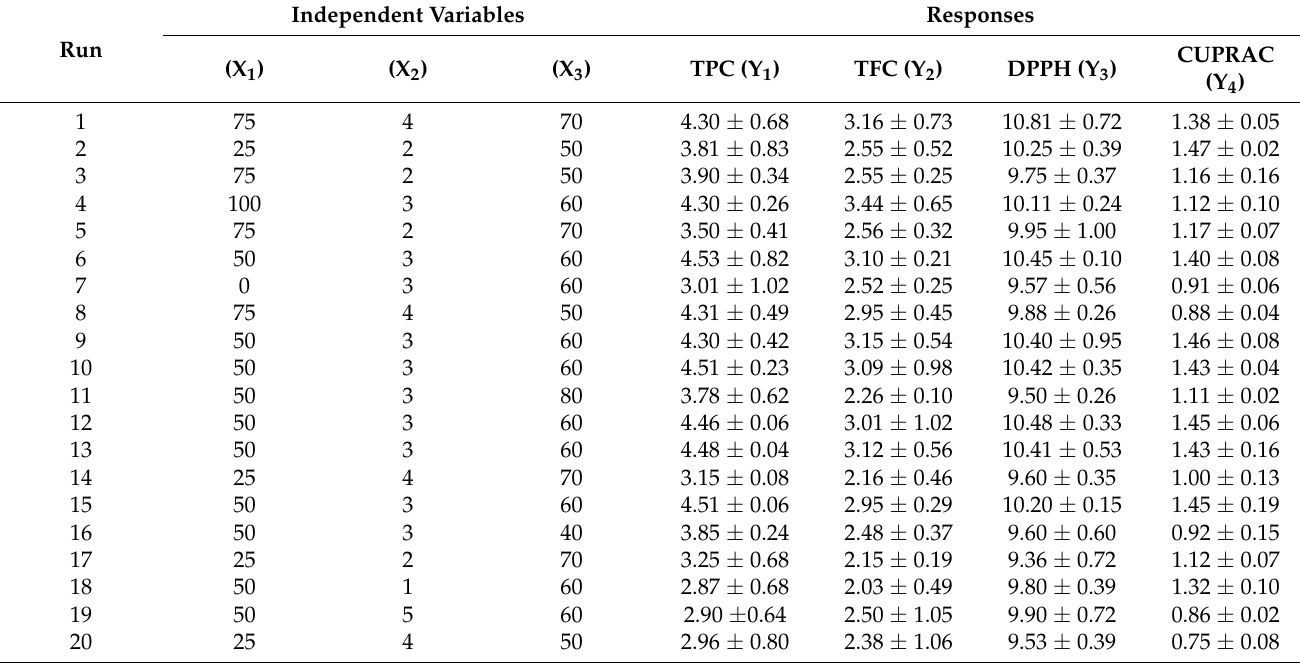
Table 1. Central composite design (CCD) for independent variables and corresponding response values